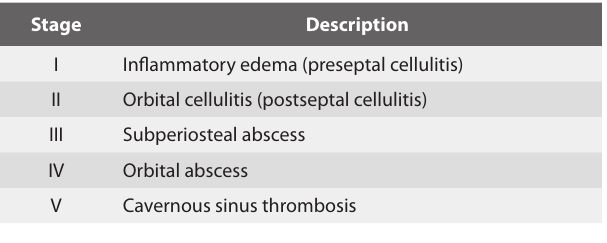
Table 1. Chandler’s classification of orbital complications of